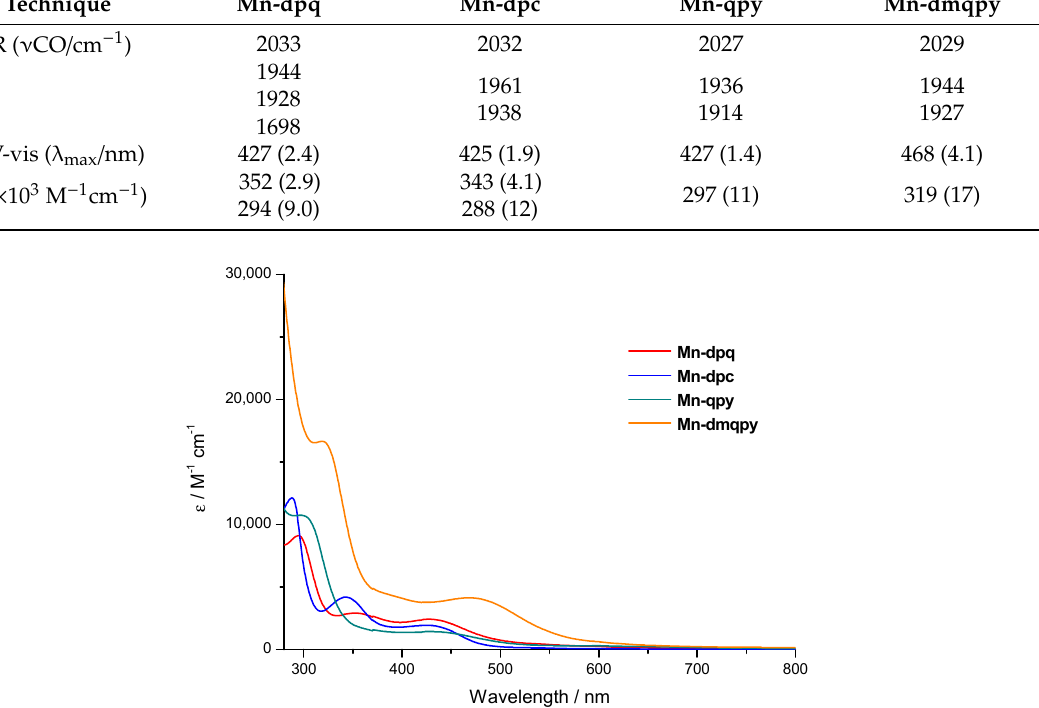
Figure 2. UV-visible spectra of the Mn(I) complexes (0.1-mM solutions in CH 3 CN). Table 1. Spectral data for the Mn(I) complexes. IR: infrared.